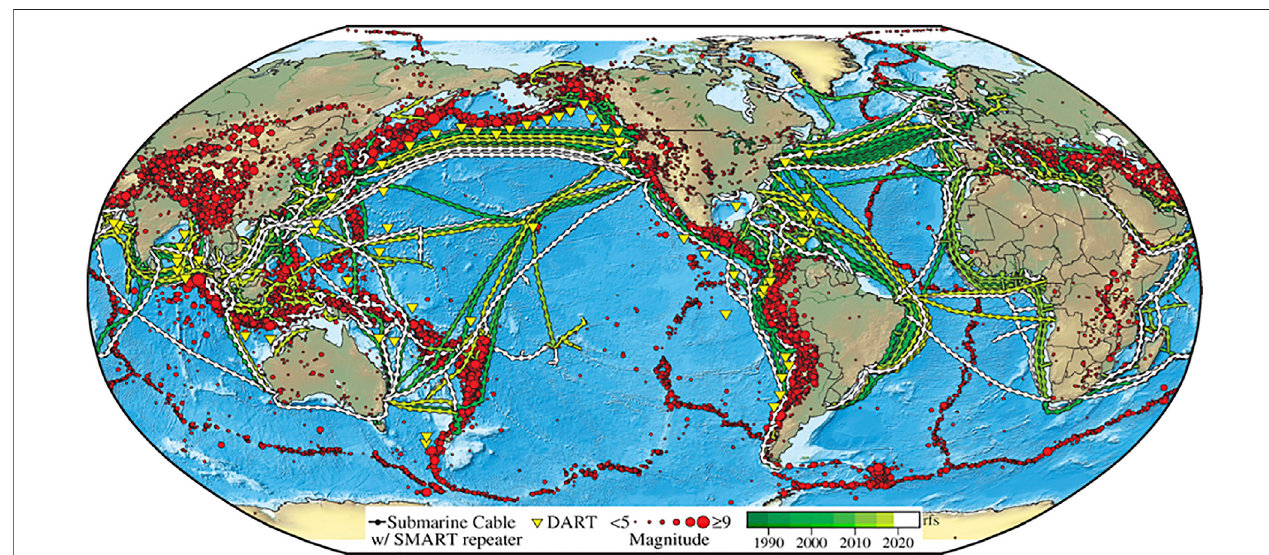
FIGURE4| Globalmapof ∼ 1millionkmofoperationalsubmarinetelecommunicationscables(greenpresent,whiteinprogress/planned;SMARTrepeatersshown every 300 km; rfs — year ready for service), historical earthquakes (red), and DART tsunami buoys (yellow triangles). Cable data: TeleGeography ’ s Telecom Resources licensed underCreativeCommonsShareAlike;DARTBuoylocations:NOAANationalDataBuoyCenter;Seismicdata:USGSEarthquakeCatalog.Permissionobtained for use of fi gure.